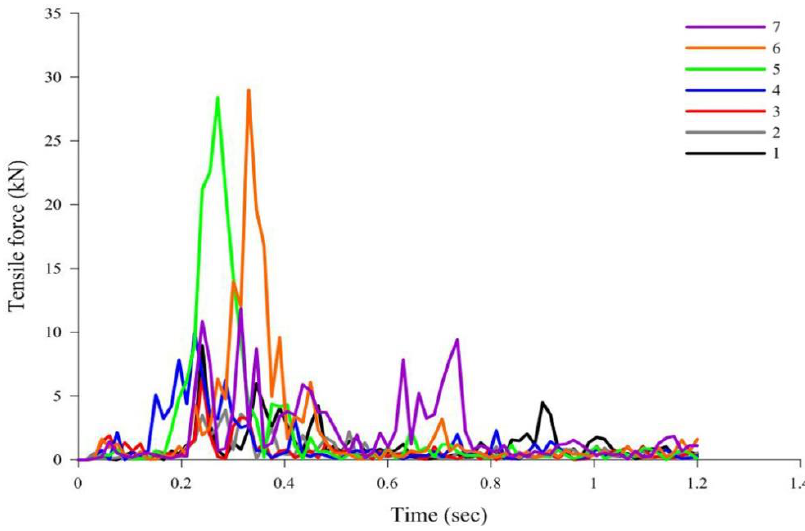
Figure 14. Tensile force acting on seven wire ropes with a brake frame.